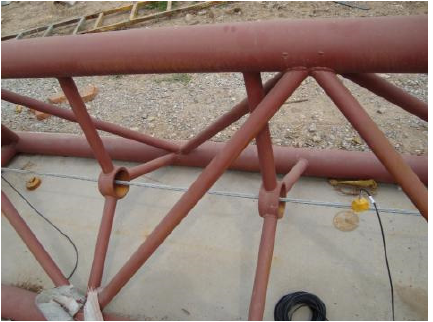
Figure 10. Bracket structure model used for the experiment.